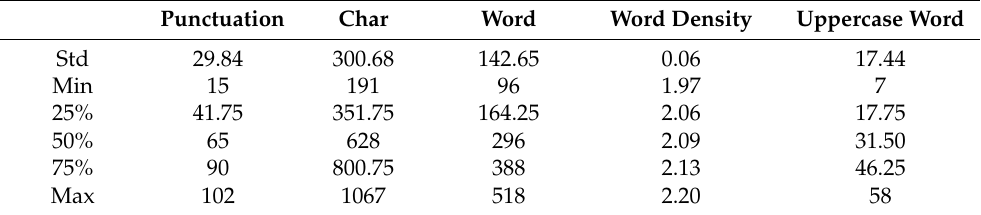
Table 2. Descriptive statistics of text data.